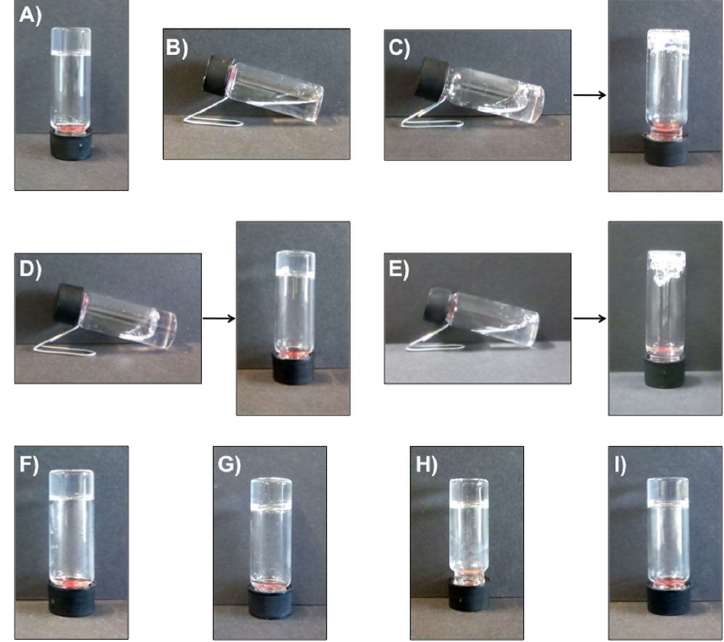
Figure 8. Representative photographs of undoped gels and gels doped with different additives under different conditions: (A ) Undoped gel made of 1b in CHCl 3 ( c = 7 g/L; 1 mL); ( B – D ) doped gels made of 1b in CHCl 3 ( c = 7 g/L; 1 mL) and mandelic acid at different molar ratios 1b :acid: ( B ) 0.9, ( C ) 0.3, ( D ) 0.1; ( E ) doped gel made of 1b in CHCl 3 ( c = 7 g/L; 1 mL) and benzoic acid (molar ratios 1b :acid = 0.9); ( F ) doped gel made of 1b in CHCl 3 ( c = 7 g/L; 1 mL) and acetic acid (molar ratio 1b :acid = 0.9); ( G ) undoped gel made of 1b in toluene ( c = 3 g/L; 1 mL); ( H ) doped gel made of 1b in toluene ( c = 3 g/L; 1 mL) and mandelic acid (molar ratio 1b :acid = 0.9); ( I ) doped gel made of 1b in toluene ( c = 3 g/L; 1 mL) and acetic acid (molar ratio 1b :acid = 0.9).